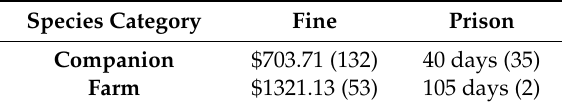
Table 4. Average penalties sentenced under section 13 of the AWA. Averages were calculated from the combination of pre and post amendments data and presented per charge of offence. Values in brackets indicate the number of charges.